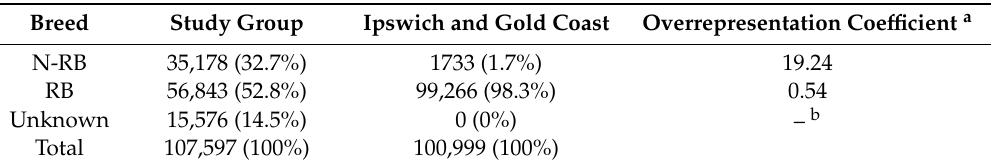
Table 1. Distribution of RB and N-RB in our study group, and in the Ipswich City Council and Gold Coast City Council registrations, with the overrepresentation coe ffi cient (both RB and N-RB were significantly di ff erent (chi-square p < 0.001).